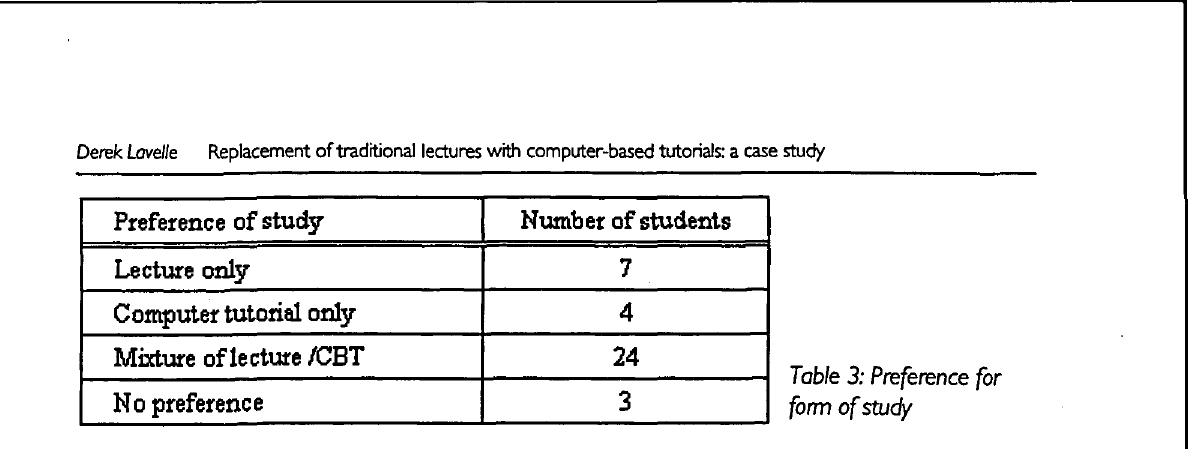
Table 3: Preference for form of